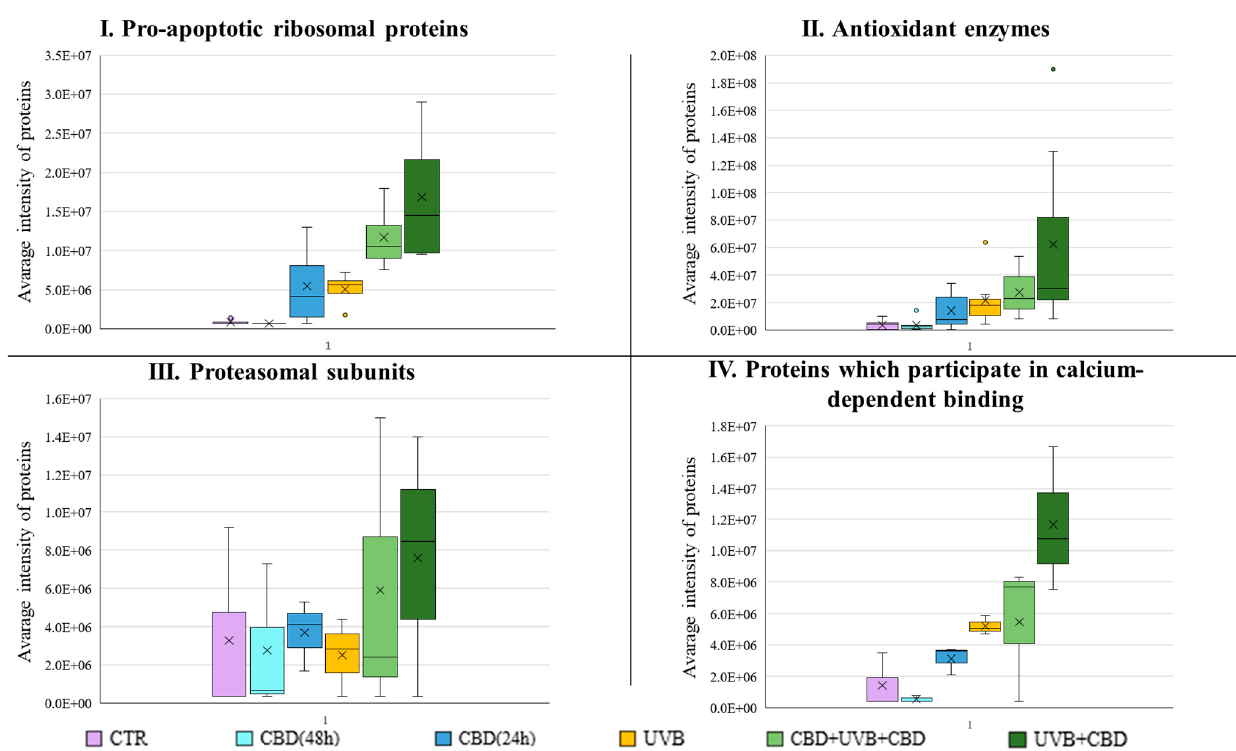
Figure 5. The box plots generated using the average intensities of the proteins in the specified protein groups: ( I ) Pro- apoptotic ribosomal proteins: ribosomal proteins S3, S19, L13a, L7a; ( II ) Antioxidant enzymes: aldo-keto reductase family 1 member A1, B1, B10, C3, carbonyl reductase [NADPH] 1, NAD(P)H dehydrogenase [quinone] 1, peroxiredoxin-1; ( III ) Proteasomal subunits: proteasome subunit alpha type-3, beta type-2, beta type-5; and ( IV ) Proteins that participate in calcium-dependent binding: EF-hand domain family-member D2, protein S100 and S100-A6. [CTR—control cells cultured with standard medium ( n = 3); CBD(48 h)—cells cultured in medium containing CBD(4 μ M) for 48 h ( n = 3); CBD(24 h) – cells cultured in medium containing CBD(4 μ M) for 24 h ( n = 3); UVB—cells irradiated with UVB (312 nm) at 60 mJ/cm 2 ( n = 3); CBD+UVB+CBD—cells cultured in medium containing CBD(4 μ M) for 24 h before and after UVB irradiation ( n = 3); UVB+CBD—cells cultured in medium containing CBD(4 μ M) for 24 h after UVB irradiation ( n = 3)].